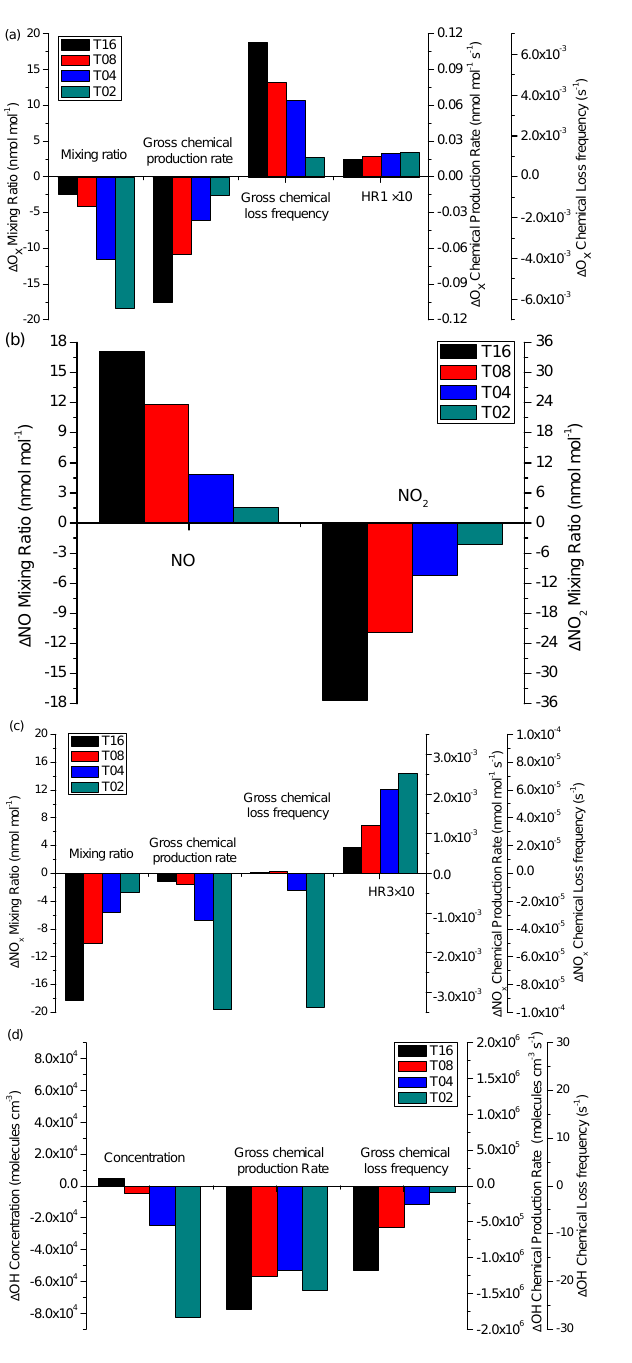
Fig. 7. Differences of the daily average mixing ratios and the gross chemical production rates B cp and the gross chemical loss frequen- cies K cl of (a) O x , (b) NO and NO 2 (c) NO x , and (d) OH, between the DUST H and NO DUST simulations (DUST H − NO DUST). The bar sequence is the same as in Fig. 5.